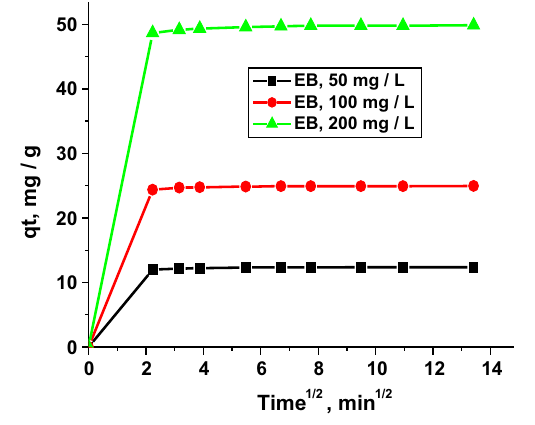
Fig. 9 Intra-particle diffusion kinetic plots for various dye EB con- centration onto SB various dye EB concentration onto SB